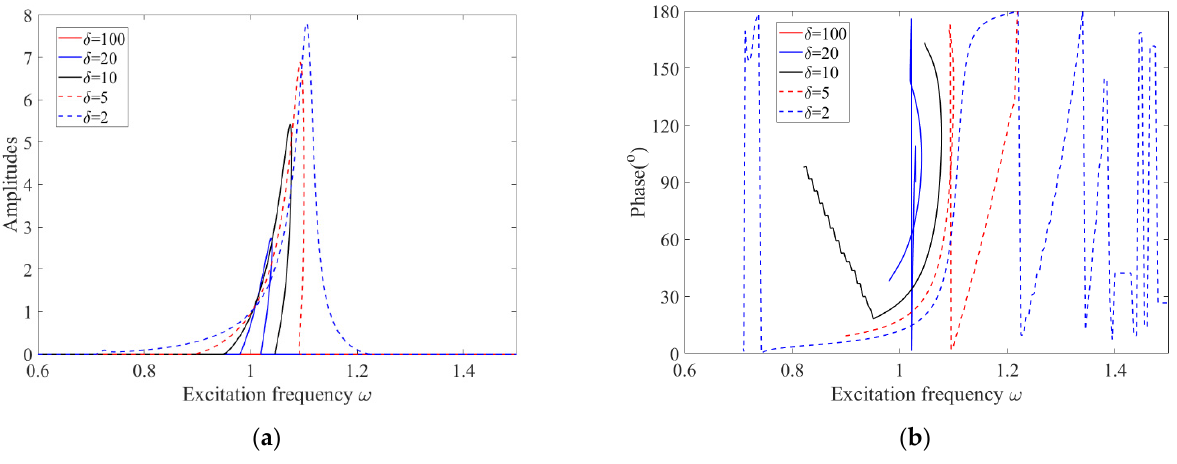
Figure 4. Amplitude–frequency characteristics and phase–frequency characteristics of Dof-2 in the system with different gaps: ( a ) amplitude–frequency characteristics; ( b ) phase–frequency characteristics.